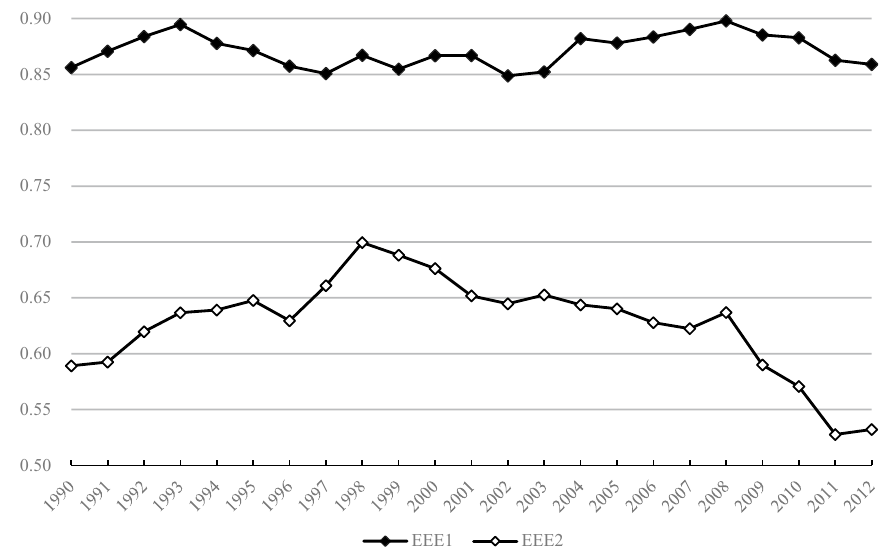
Fig. 1 Changes in EEE1 and EEE2 for the manufacturing sector (1990–2012). The values in the figure are the arithmetic mean based on the measurement results by